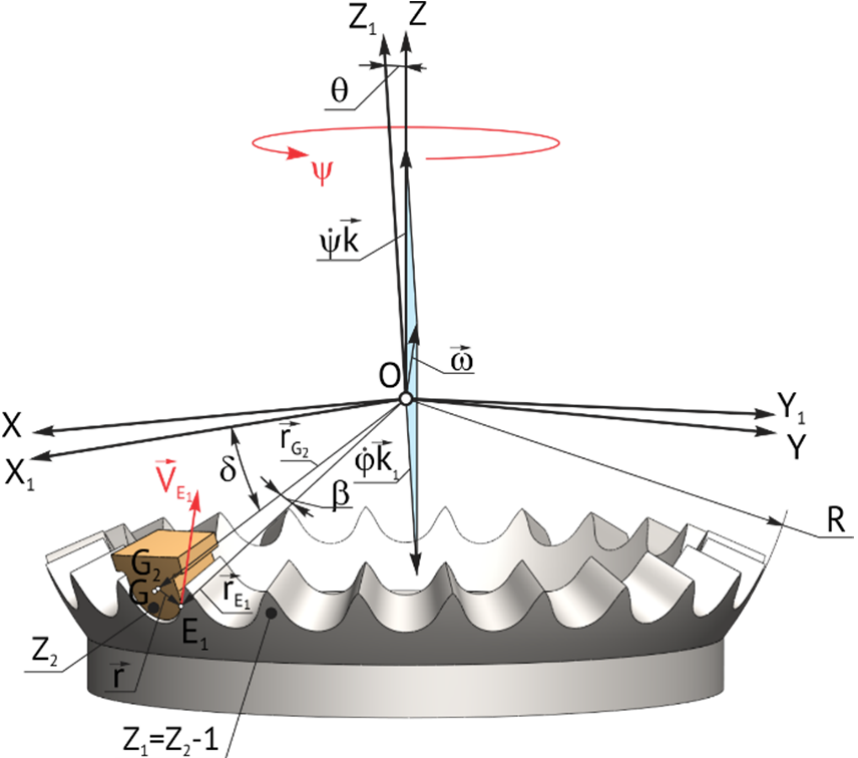
V and V on the 1 E 2 E